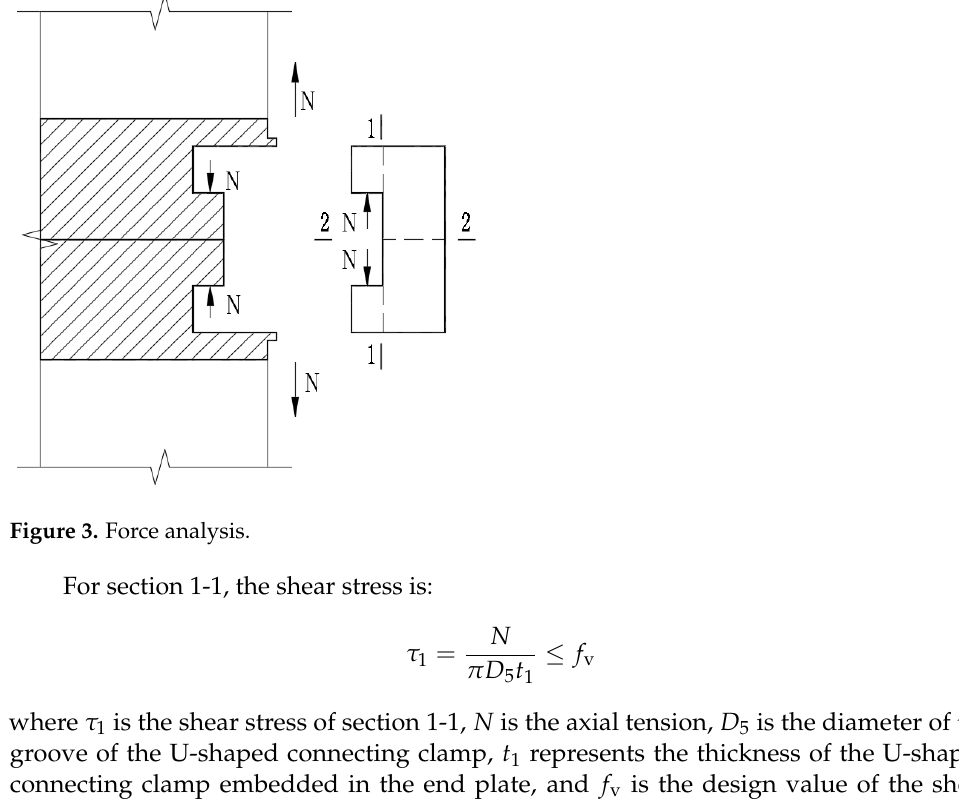
Figure 2. Combination Splice.